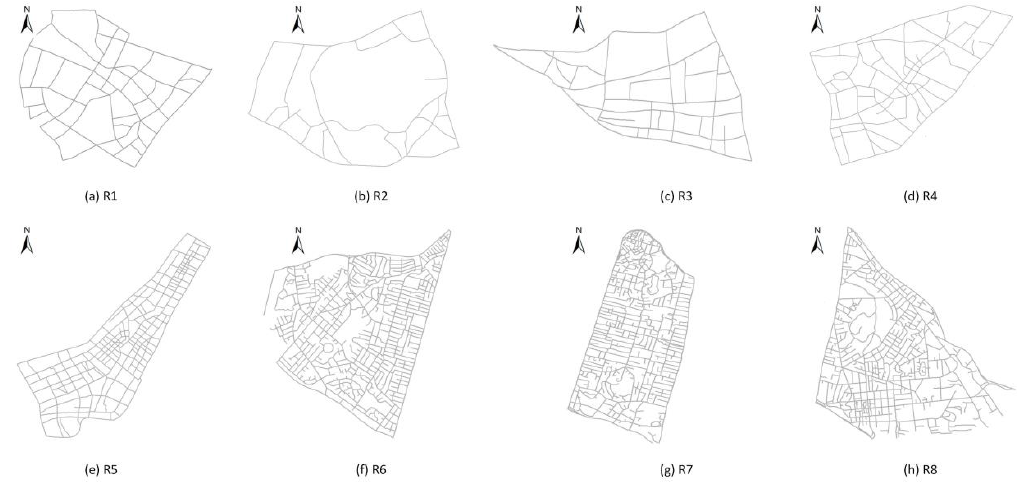
Figure 16. Eight experimental subregions ( a ) R1, ( b ) R2, ( c ) R3, ( d ) R4, ( e ) R5, ( f ) R6, ( g ) R7, and ( h )